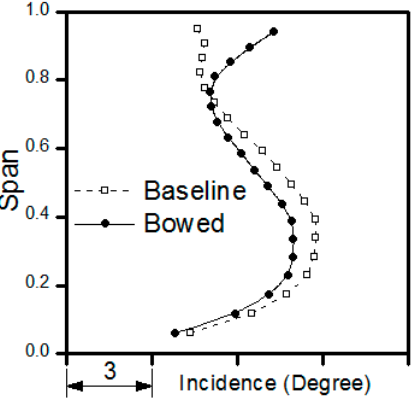
Figure 15. Spanwise distributions of the incidence at the design point. Energies 2016 , 9 , 296